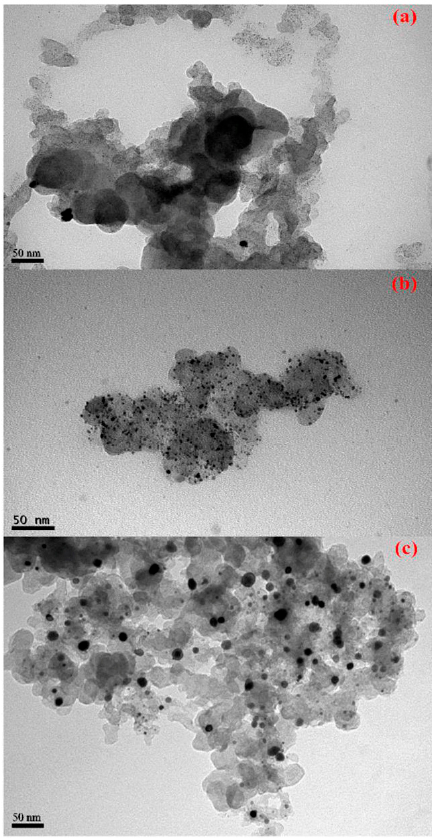
Figure 5. TEM micrographs of various Pt-loaded PANFs ( a ) Pt/XC72-HT; ( b ) Pt/XC72-MW; and ( c ) Pt/XC72-PPDA-MW.